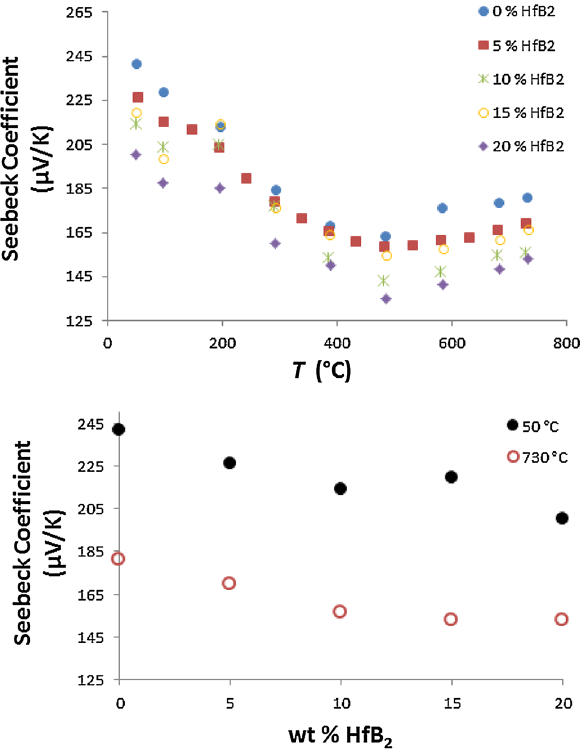
Fig. 3 Seebeck coefficient as a function of ( top ) temperature and ( bottom ) hafnium diboride